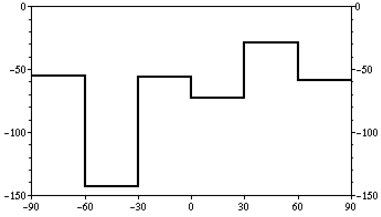
Fig. 6. Latitudinal distribution of differences between the numbers of the eastern and the western SOHO LASCO 1996-2004 CMEs, calculated in 30 ◦ bins.